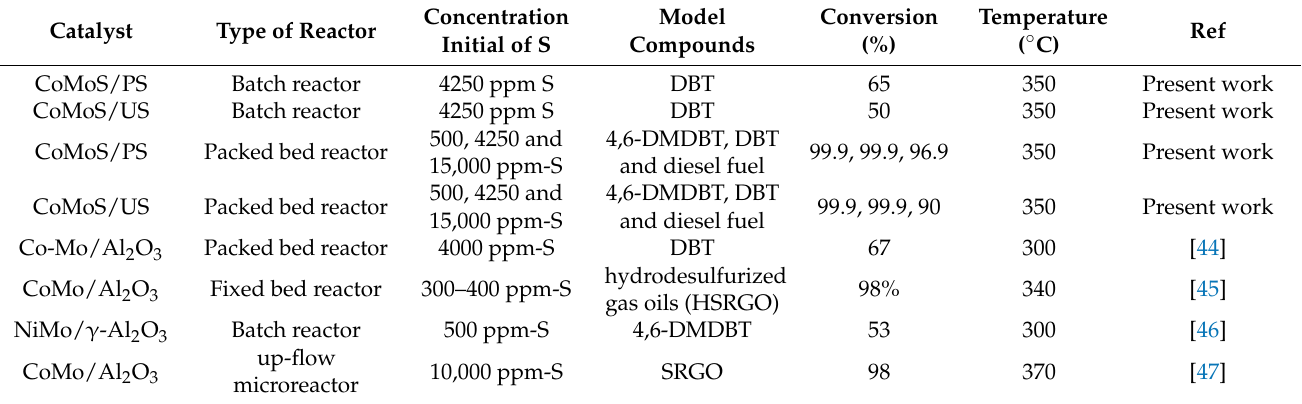
Table 5. Comparison of the HDS catalytic efficiency of different catalysts supported on